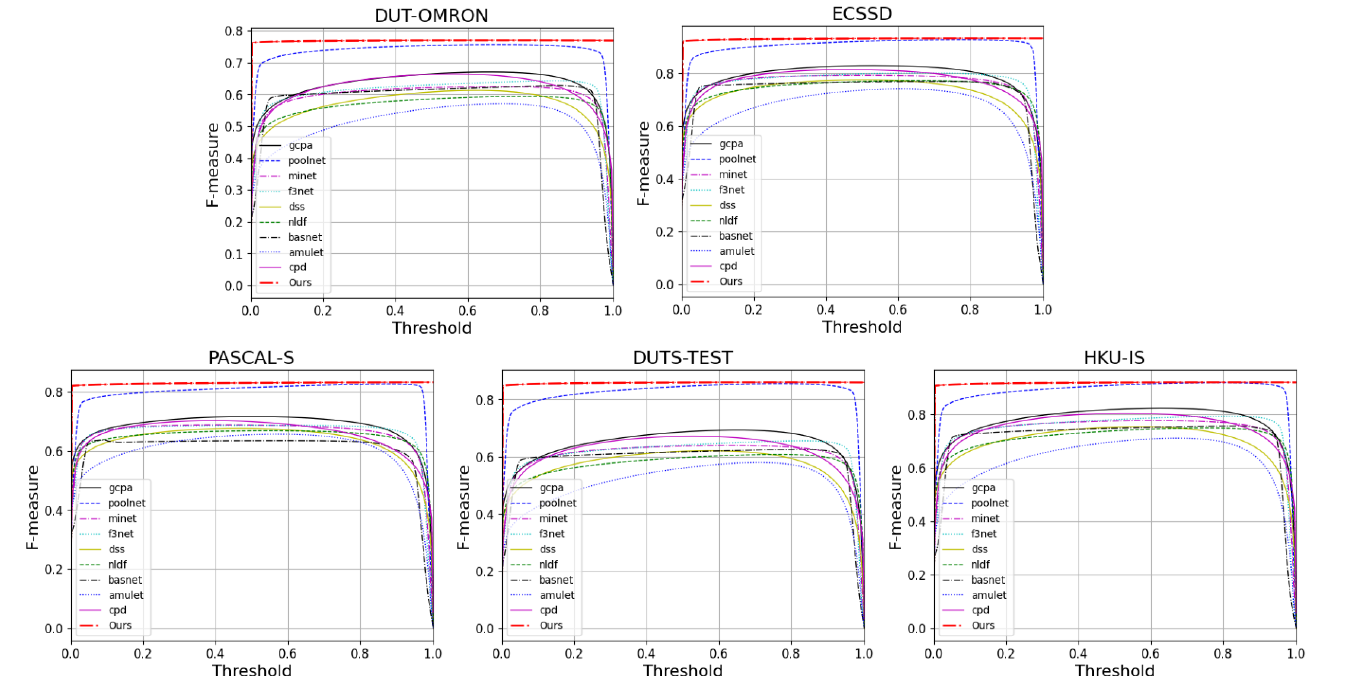
Figure 5. The PR curves of FRNet and the other nine advanced models on five datasets.